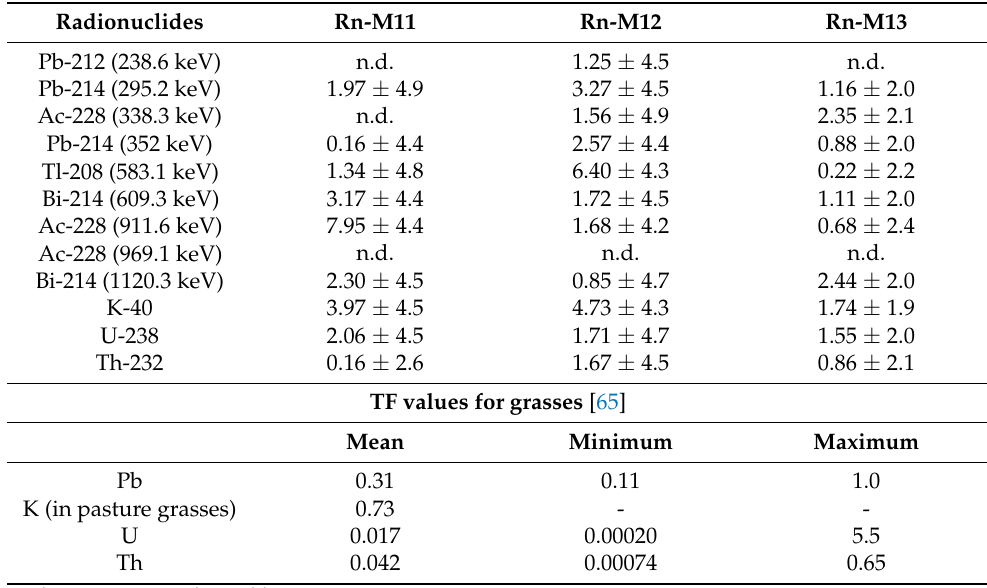
Table 2. Transfer factors calculated from 0–25 cm soil